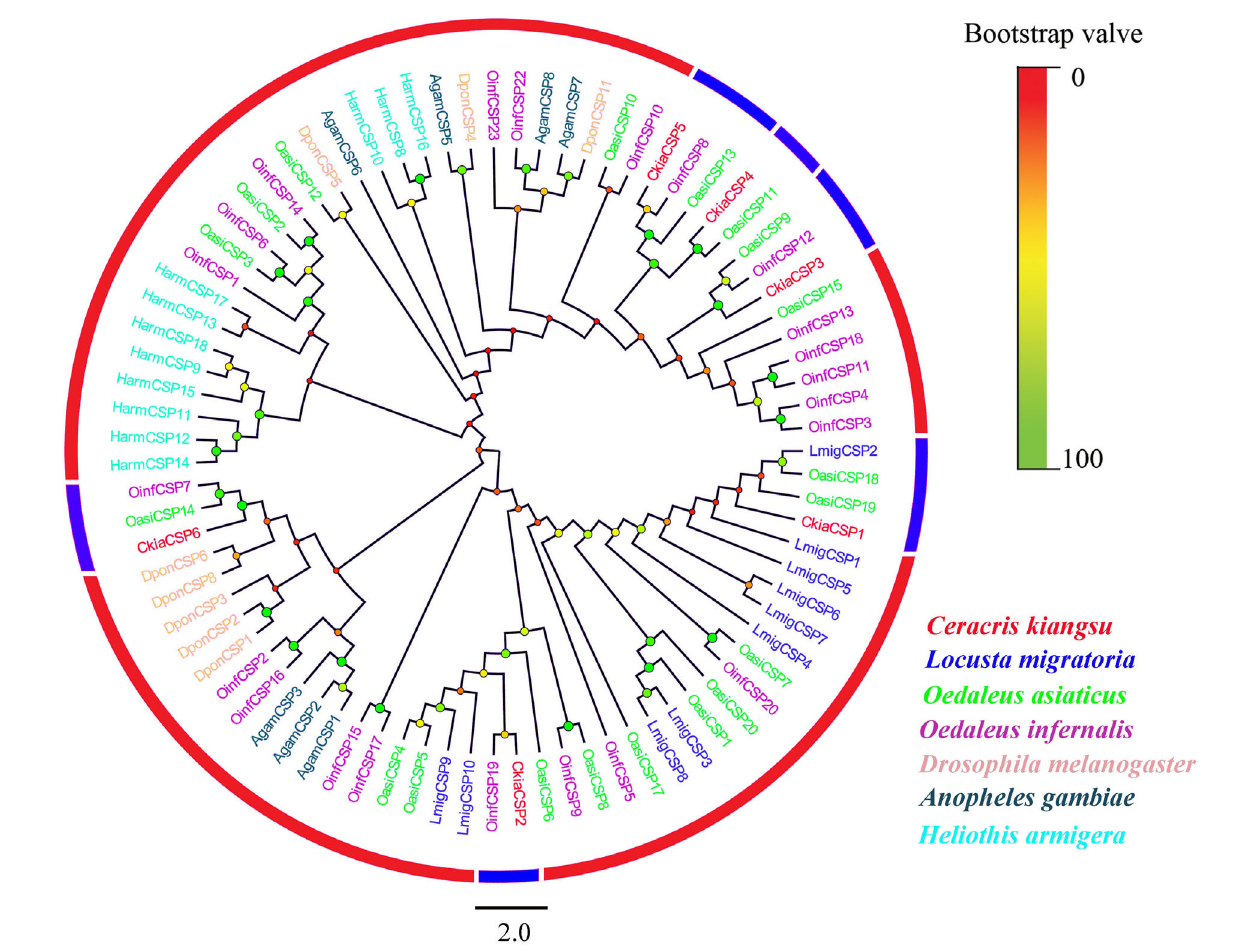
FIGURE 5 | Phylogenetic tree of putative chemosensory-binding proteins (CSPs) from C. kiangsu and other insects. Branch support (circles at the branch nodes) was estimated using bootstrap values based on the scale indicated on the top right.